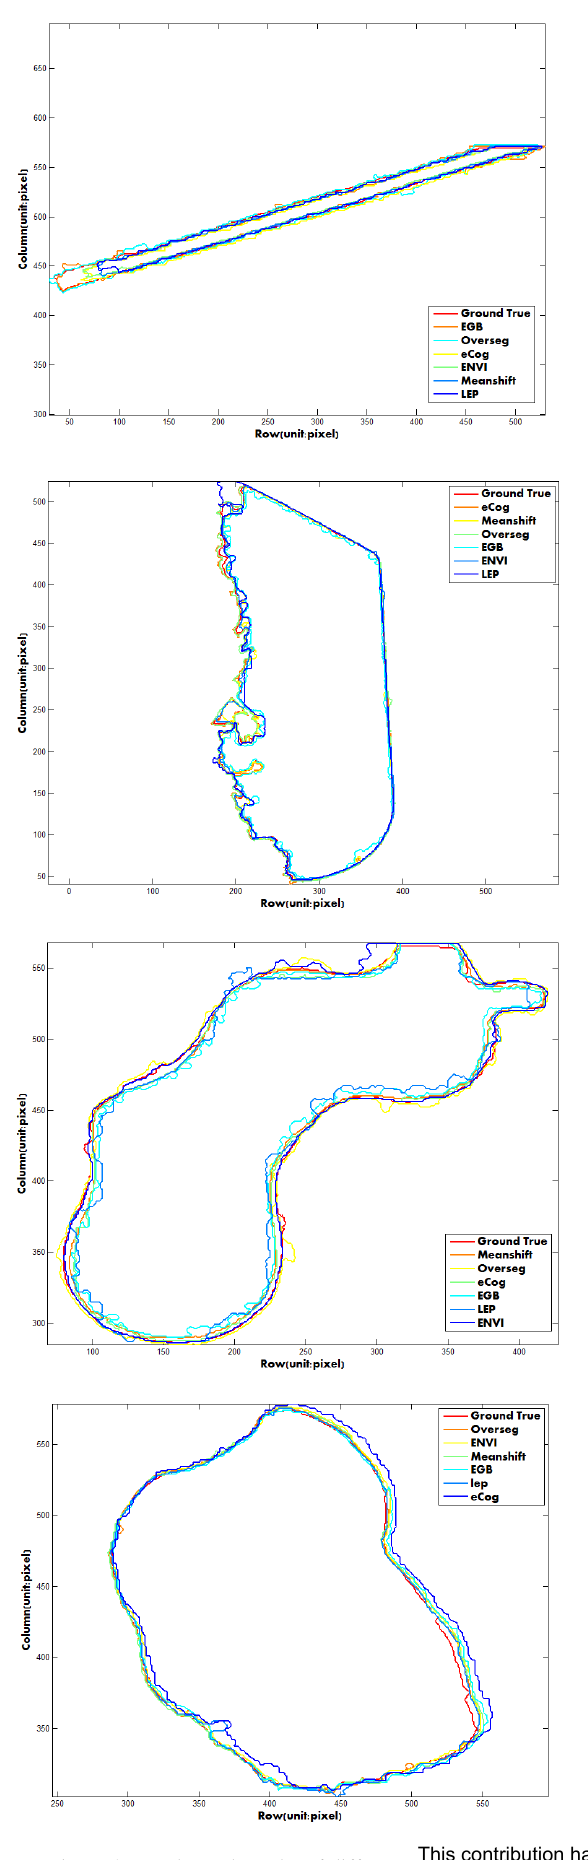
Figure 2: overlapped results of different